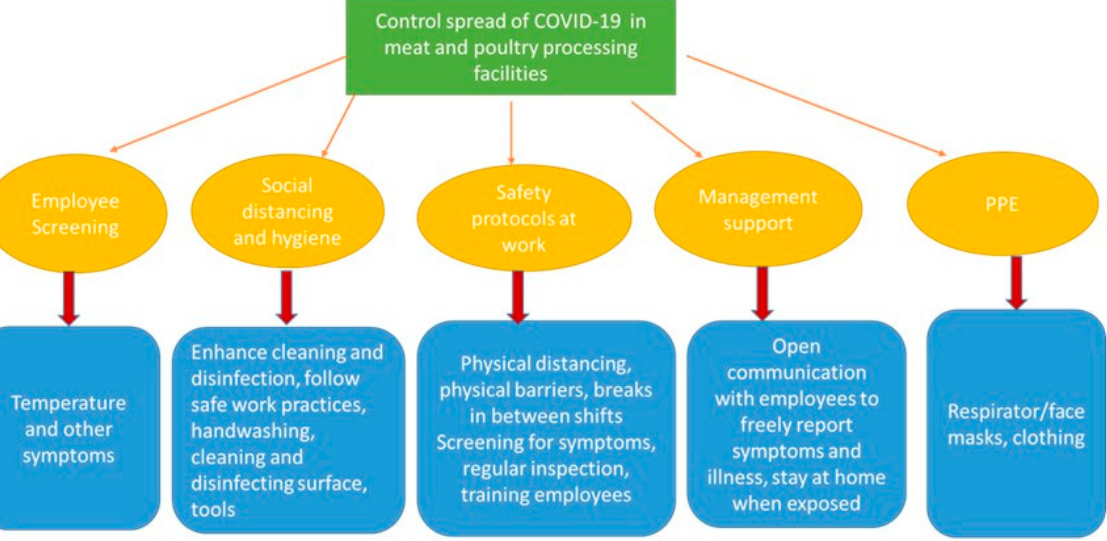
Figure 2. Best practices to control rapid spread of COVID-19 among workers in meat and poultry processing facilities.